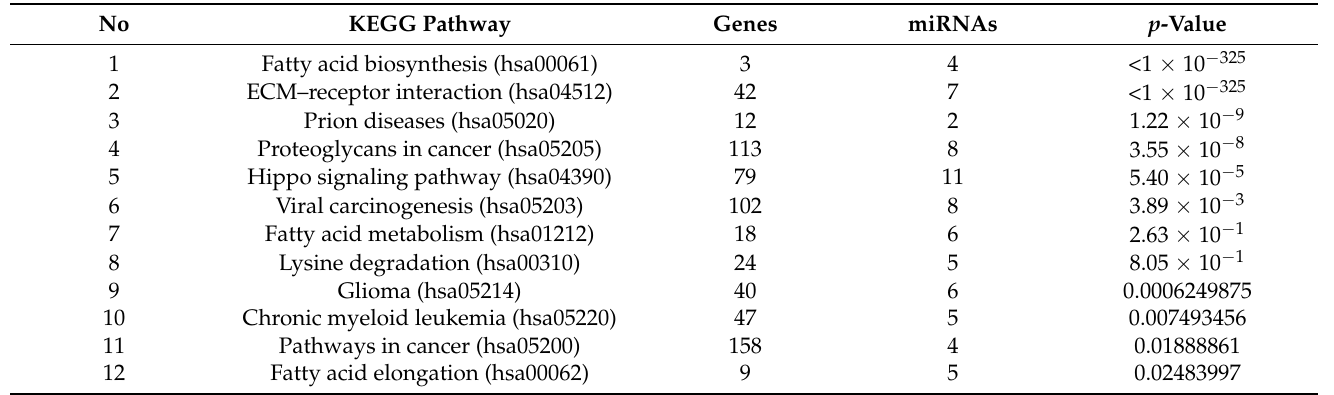
Table 3. Interaction of upregulated and downregulated miRNAs with pathways after in silico analysis with DIANA miRPath v3.0 online software.